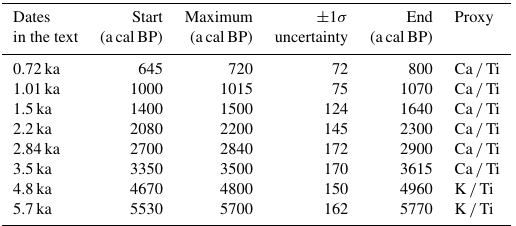
Table 3. Time uncertainty (1 σ ) of “wet” events identified by the Ca / Ti and K / Ti ratios (Fig.